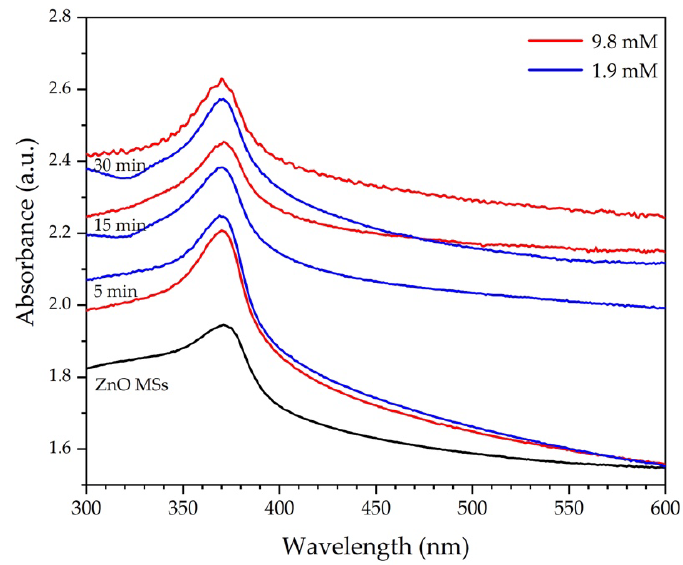
Figure 6. UV-Vis absorption spectra of ZnO MS (black line) and Ag/ZnO MSs obtained at 1.9 (blue lines) and 9.8 mM of AgNO 3 (red lines), at 5, 15, and 30 min of photodeposition.